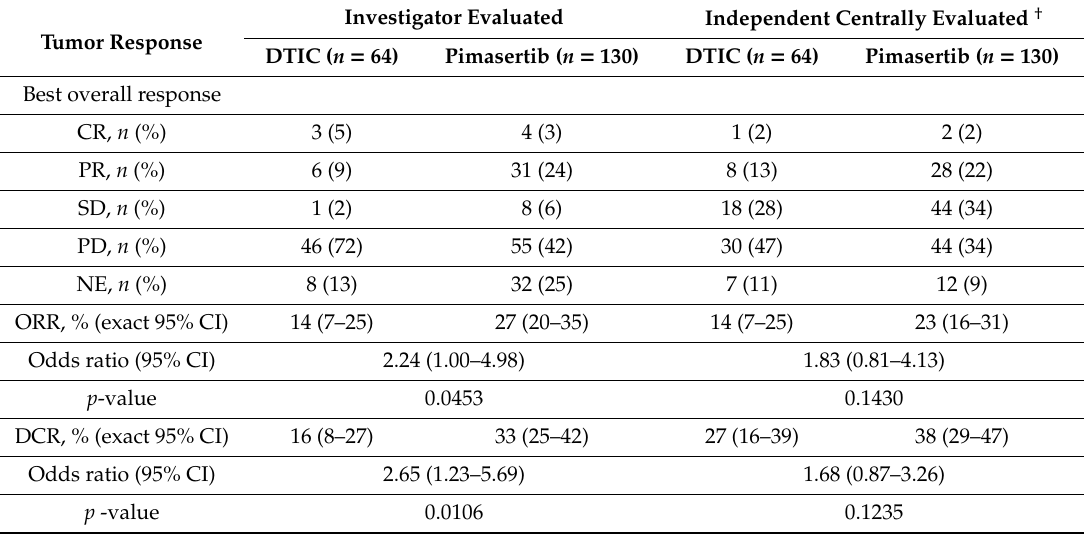
Table 2. Best overall response, ORR and DCR based on investigator and independent evaluation of data (ITT analysis set) 1